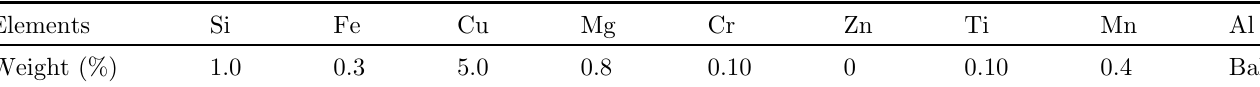
Table 1. Chemistry of Al2214 Alloy. Elements